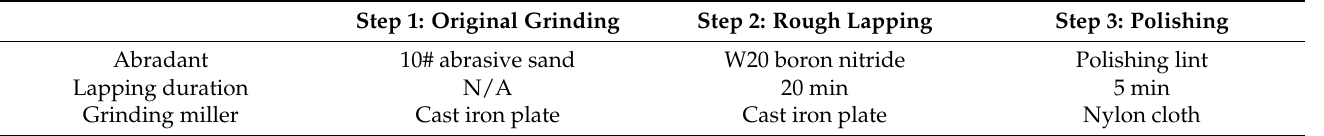
Table 3. Machining information of additional experiment sample surface of 9Cr18Mo.